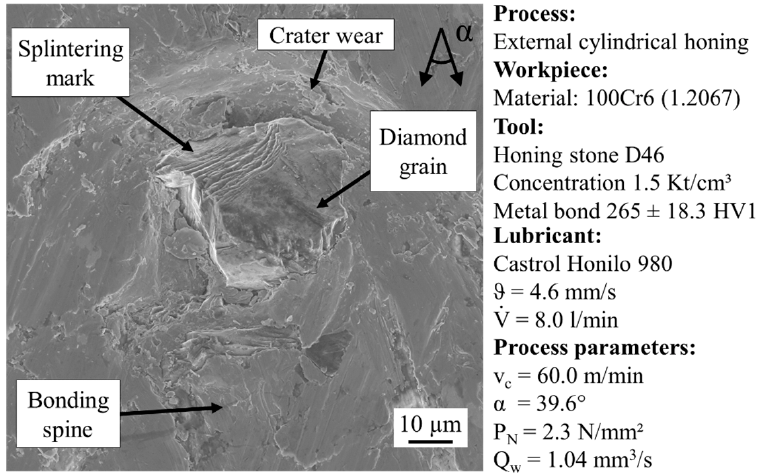
Figure 7. Wear marks for intermediate honing.